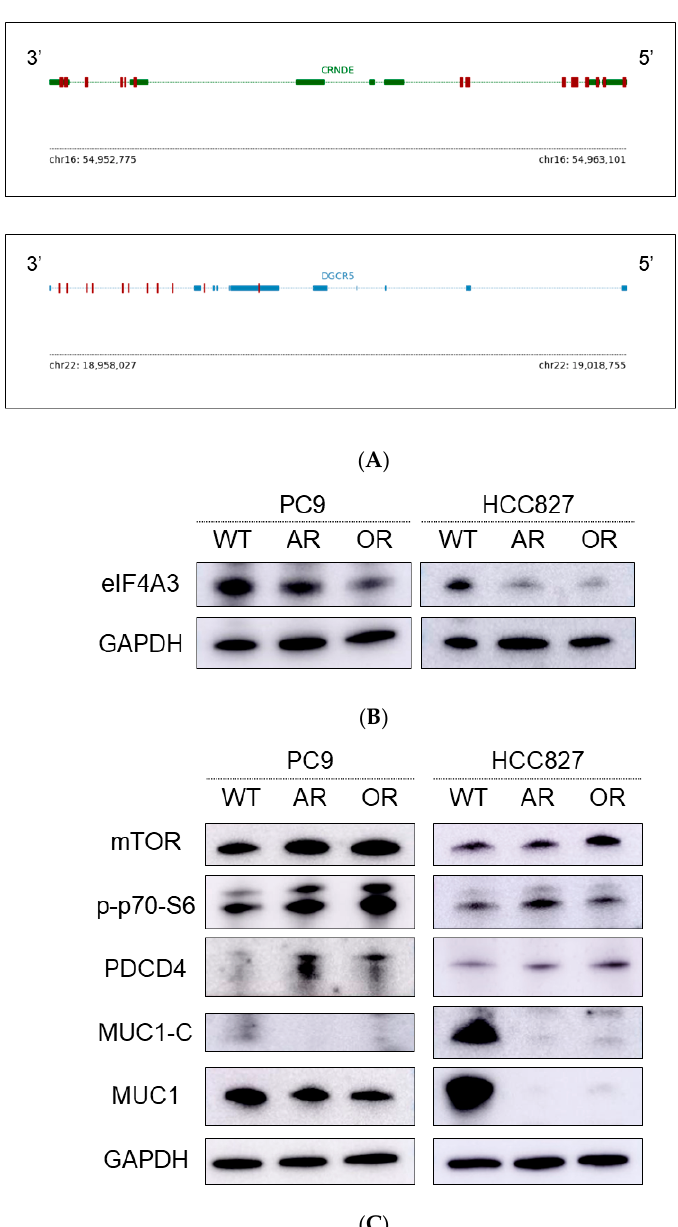
Figure 3. CRNDE decreased the levels of eIF4A3 downstream molecules by binding eIF4A3 in EGFR-TKI-resistant NSCLC cells ( A ) A motif of the eIF4A3-binding site on CRNDE. eIF4A3-binding sites are shown as red rectangles. ( B ) Western blotting analysis showed that eIF4A3 expression declined in the EGFR-TKI-resistant cells. ( C ) Western blotting analysis demonstrated increased protein expression of the AKT/mTOR signaling molecules and decreased protein expression of the eIF4A downstream signaling molecules in EGFR-TKI-resistant cells.